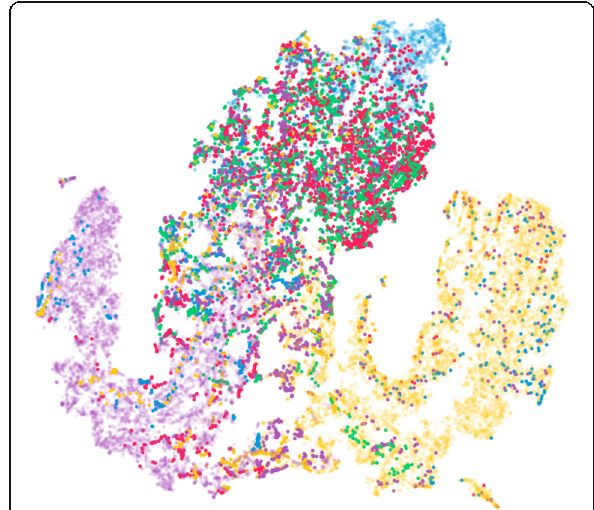
Fig. 3 Projection for the Reuters dataset. The data points of the sequences are colored according to their actual class instead of the classification result. In addition, points that belong to correctly classified sequences are more transparent. This visualization helps identify areas where hidden states generate possibly incorrect model outputs. At the top, most sequences were classified as money-fx (blue) instead of crude-oil (green) or grain (red). Underlying data source: Reuters